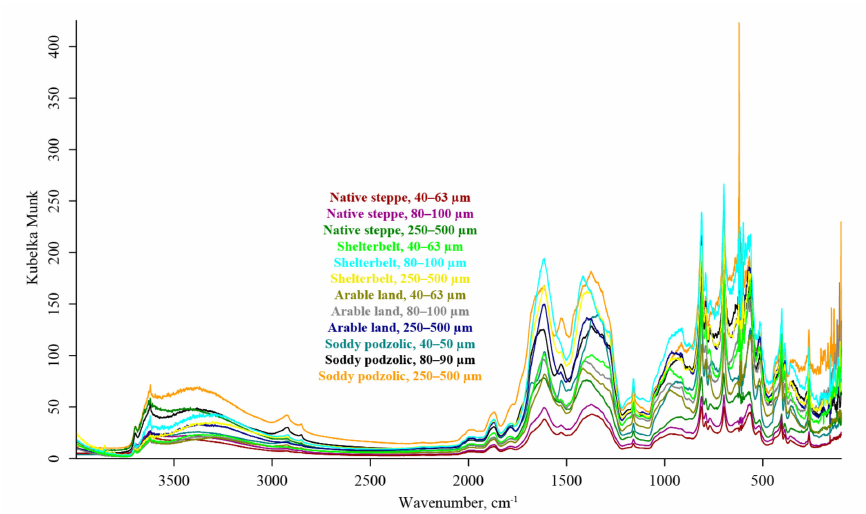
Figure 1. DRIFT spectra of fractions of chernozem and sod-podzolic soils. Chernozem native steppe, 40–63 µ m, dark red; 80–100 µ m, magenta; 250–500 µ m, dark green; chernozem shelterbelt, 40–63 µ m, light green; 80–100 µ m, light blue; 250–500 µ m, yellow; chernozem arable land, 40–63 µ m, khaki; 80–100 µ m, gray; 250–500 µ m, dark blue; sod-podzolic, 40–50 µ m, dark cyan; 80–90 µ m, black; 250–500 µ m, orange.